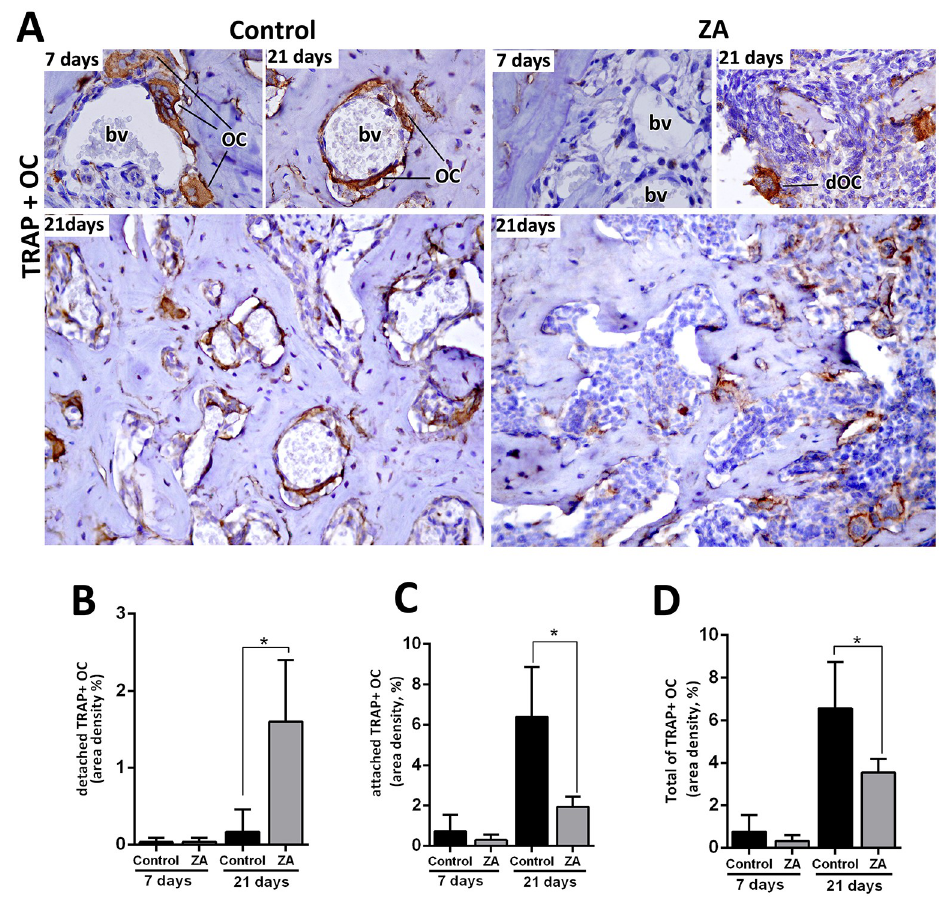
Fig 6. Immunolabeling and quantification of TRAP+OC in the control and ZA treated mice. Senescent 129 Sv-WT female mice received IP injections of 0.9% saline solution (Vehicle) or 250 μ g/Kg one a week and upper right incisor were removed after 4 weeks of Vehicle or ZA treatments. Mice were euthanized for maxillary bones removal after 7days and 21days post tooth extraction. A) Representative transversal sections are observed throughout days 7 and 21, from the central area of alveolar sockets, for TRAP+OC in Control and ZA group. B-E) Quantitative and comparative analysis of detached TRAP+ OC (B), attached TRAP+ OC (C) and the Total of TRAP+OC considering the sum of detached and attached TRAP+ OC (D) in control vs ZA treated mice at days 7 and 21 post-extraction. Results are presented as the means ( ± SD) of area density (%). Symbol � indicate a statistically significant difference vs control (p < 0.05). DAB chromogen and counterstaining with Harris’